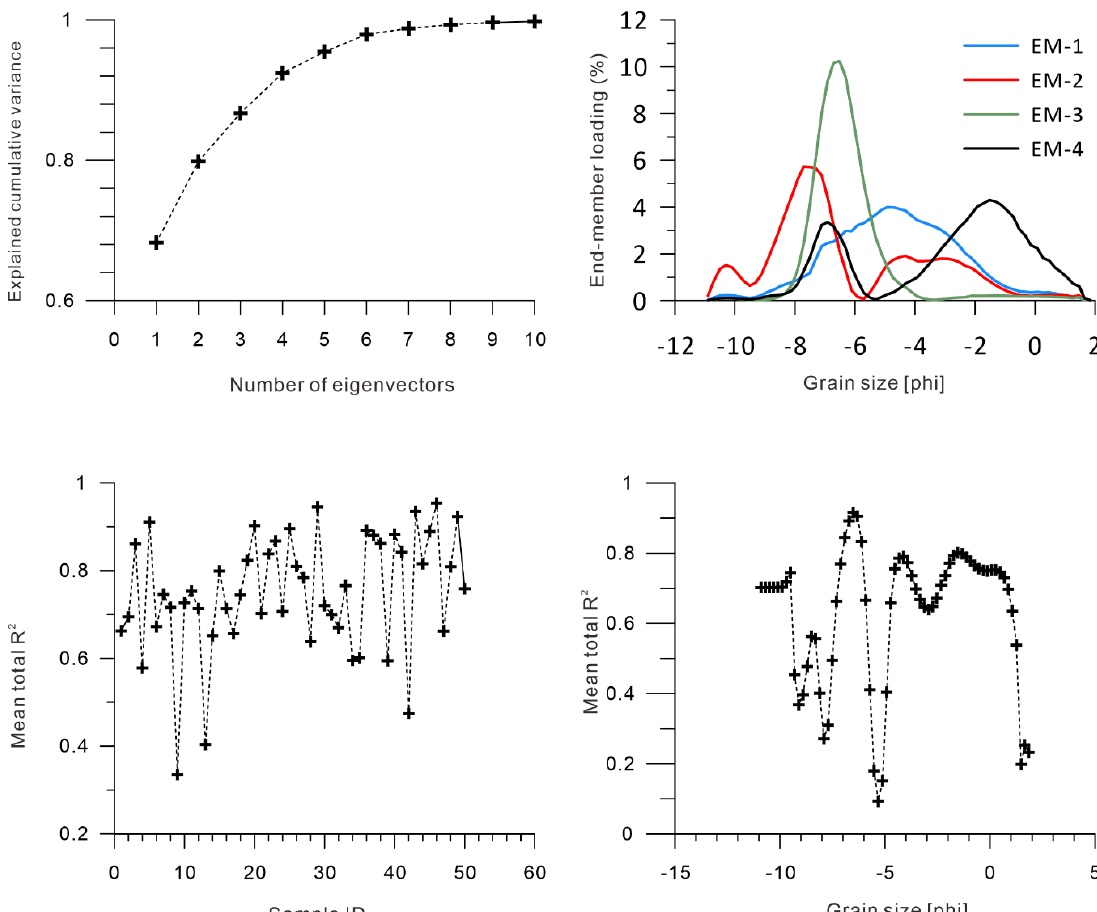
Figure 4. Grain-size data using the algorithm of end-member modelling analysis (EMMA) [39] .